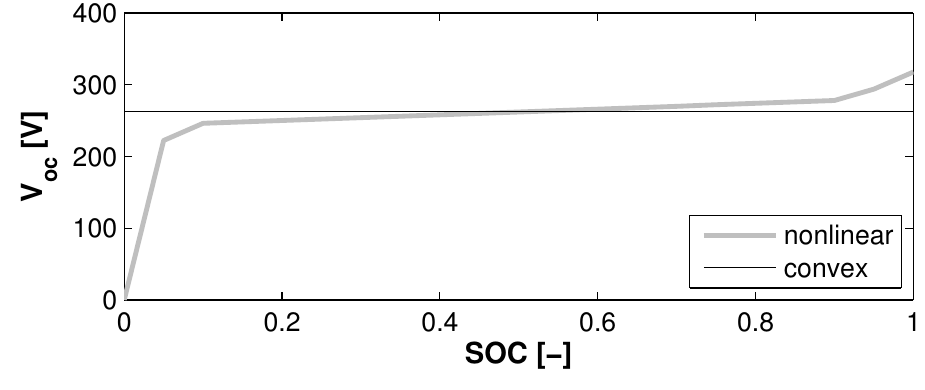
Figure 4. Comparison of the nonlinear and the approximated model for the open-circuit voltage of the